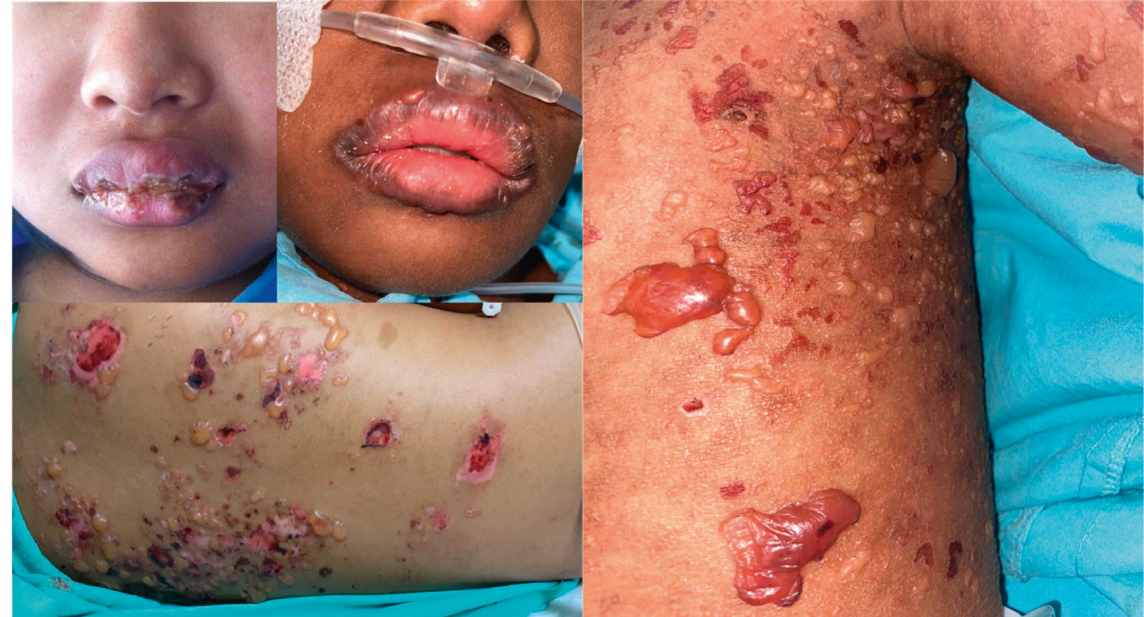
Figure 1: Generalized tense bullae, and extensive vesicles on the lips, perioral, and mucosal areas in patients with bullous systemic lupus